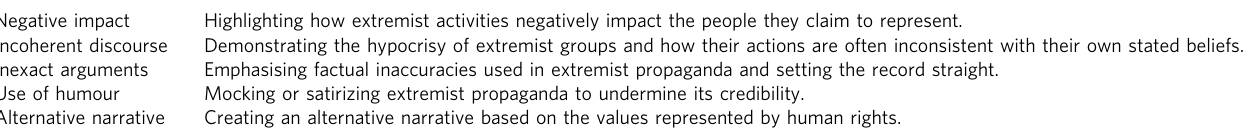
Table 3 Categories of analysis for future teachers ’ responses in activity 2 based on the works of Tuck and Silverman (2016) and European Council (2017). Negative impact